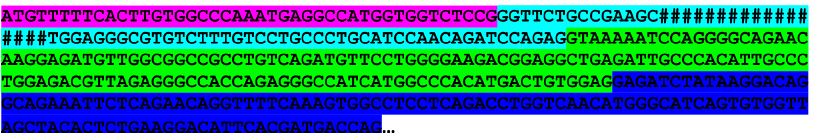
Figure 5. Consequences of the CRISPR/Cas9-mediated FLOT1 knockout in HeLa cells at mRNA level. Total RNA was isolated from the WT and knockout HeLa clones and reverse-transcribed. The coding region of flotillin-1 was amplified with specific primers, cloned into a vector, and six plasmid clones were sequenced. ( a ) WT human flotillin-1 coding region (exons 2–6 only) with color-coded exons (pink: exon 2 beginning from the ATG start codon); ( b ) clone 2 with insertion of an A in exon 3 and exon 4 spliced out; ( c ) clone 2: exons 3–5 spliced out; ( d ) clone 2: exon 3 spliced out; ( e ) clone 7: deletion of 17 nucleotides (marked with #), exon 4 spliced out.